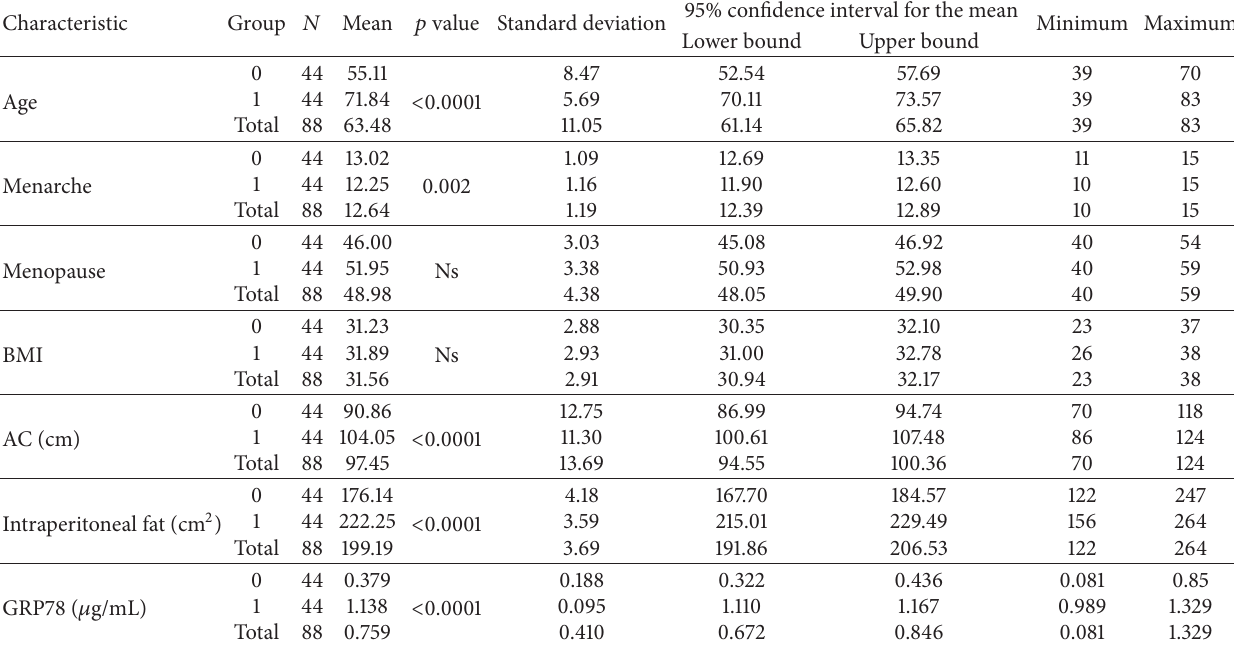
Table 1: Characteristics of the patients included in the study.